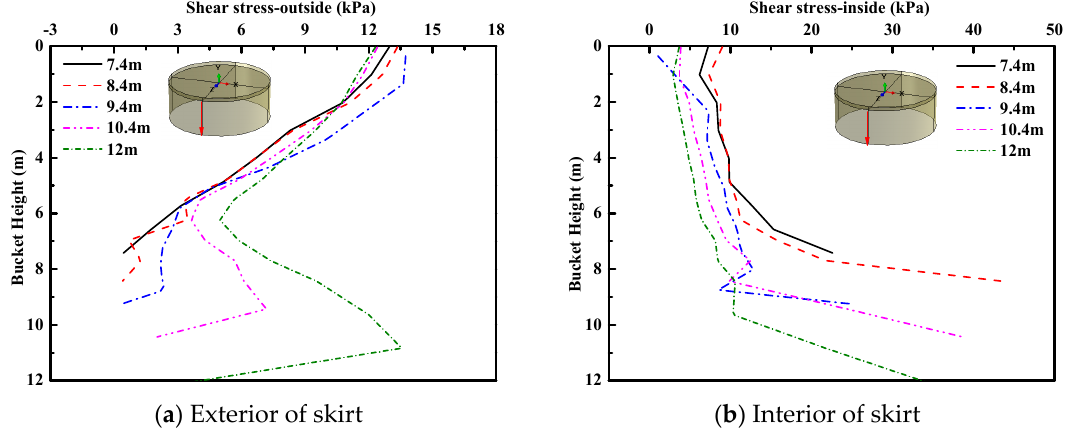
Figure 9. Shear stress of skirt under different bucket skirt heights.